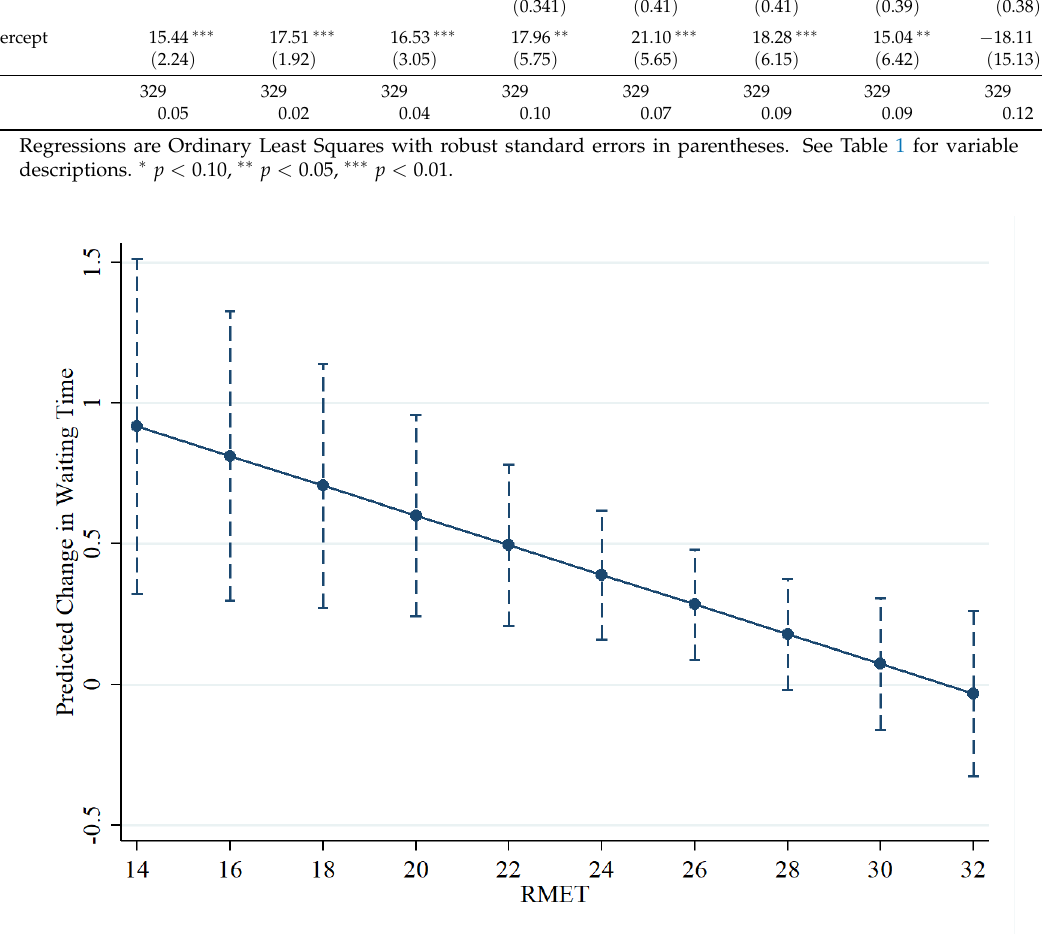
Figure 4. Marginal effects of change in shame negative-self-evaluation (shame-NSE) on waiting time at different RMET scores. Note: This figure uses the regression results from column (8) in Table 3 which included the interaction variable Shame-NSE X RMET. Marginal effects of a unit change of Shame-NSE on Waiting time was calculated by taking the derivative with respect to Shame-NSE and estimating this effect at different RMET Scores. Dashed lines indicate 95% Confidence